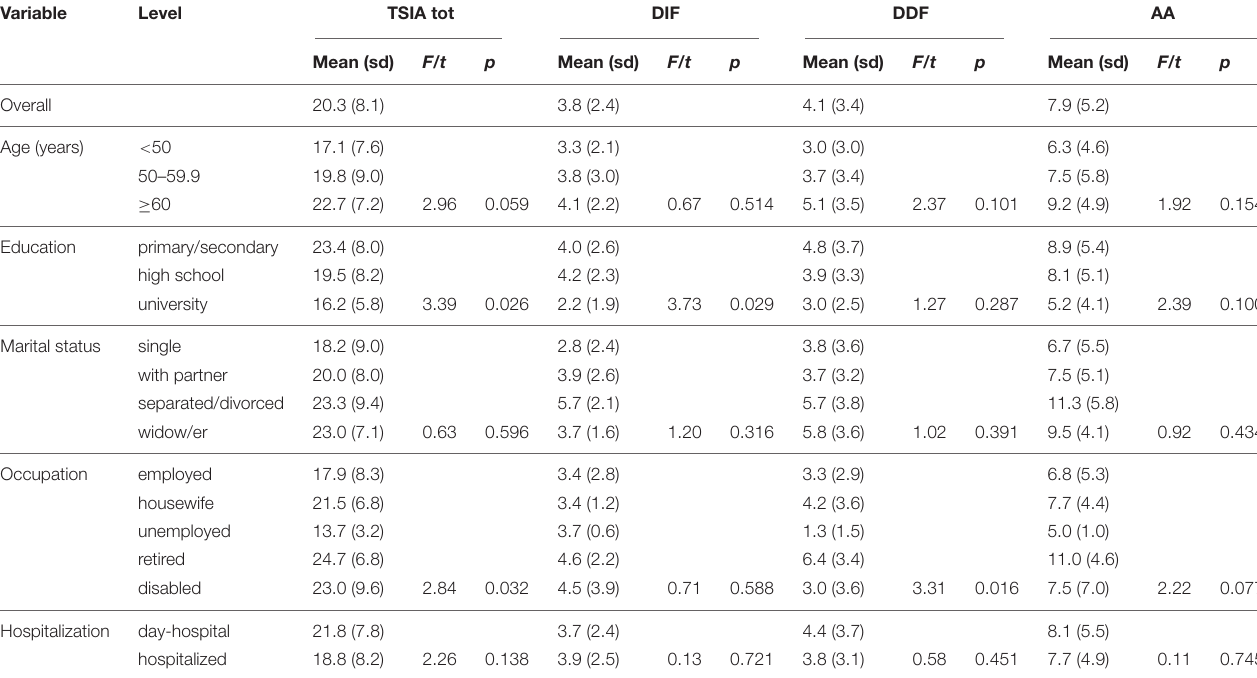
TABLE 3 | Mean values of the TSIA total score and sub-dimensions DIF, DDF, and AA in different subgroups of patients. Variable